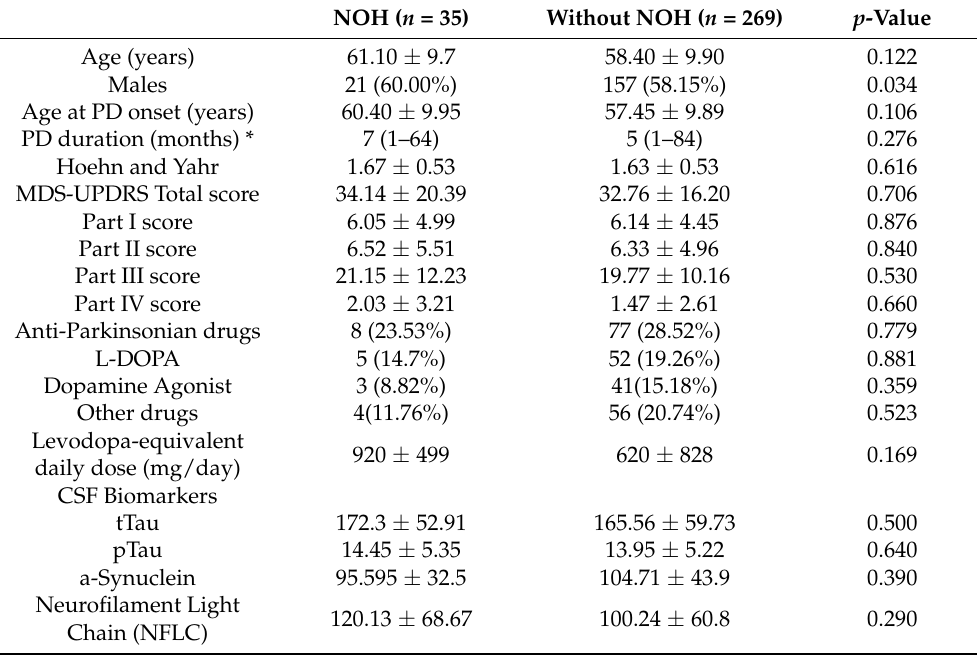
Table 1. Characteristics of PD patients with and without Neurogenic Orthostatic Hypotension. NOH ( n = 35) Without NOH ( n = 269) p